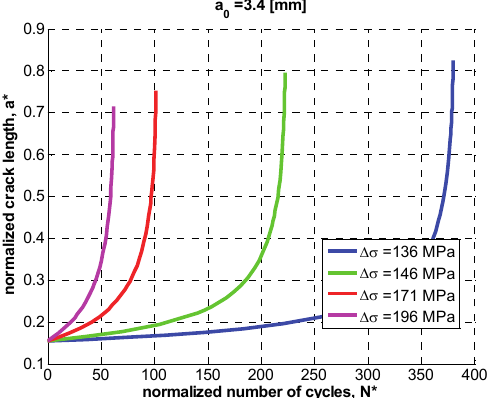
Figure 7: Curves a*-N* for different initial crack sizes a 0 *, while maintaining constant Δσ *.